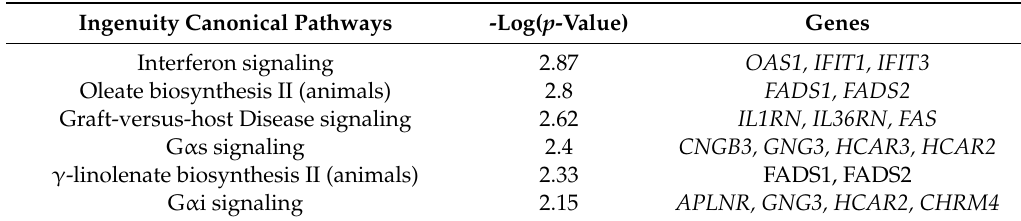
Table 2. Canonical Pathways identified by Ingenuity ® Pathway Analysis